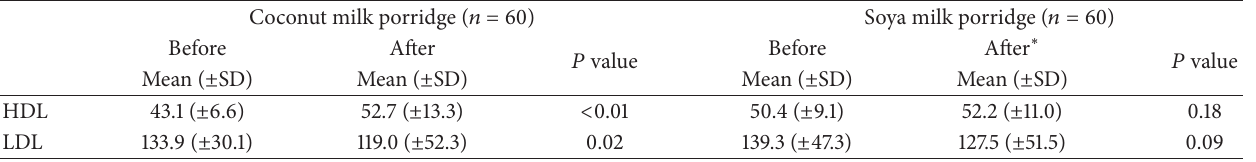
Table 2: LDL and HDL levels (mg/dL) of the sample subjects before and after the consumption of coconut porridge and soya porridge.